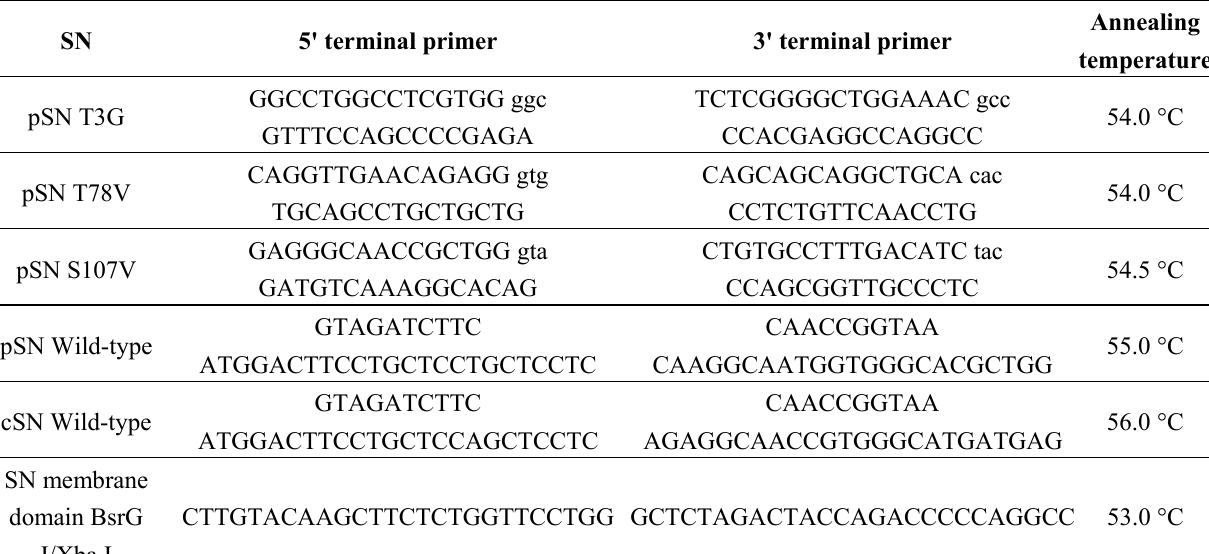
Table 4. Primers used to construct six SN N -terminal and trans-membrane domains.